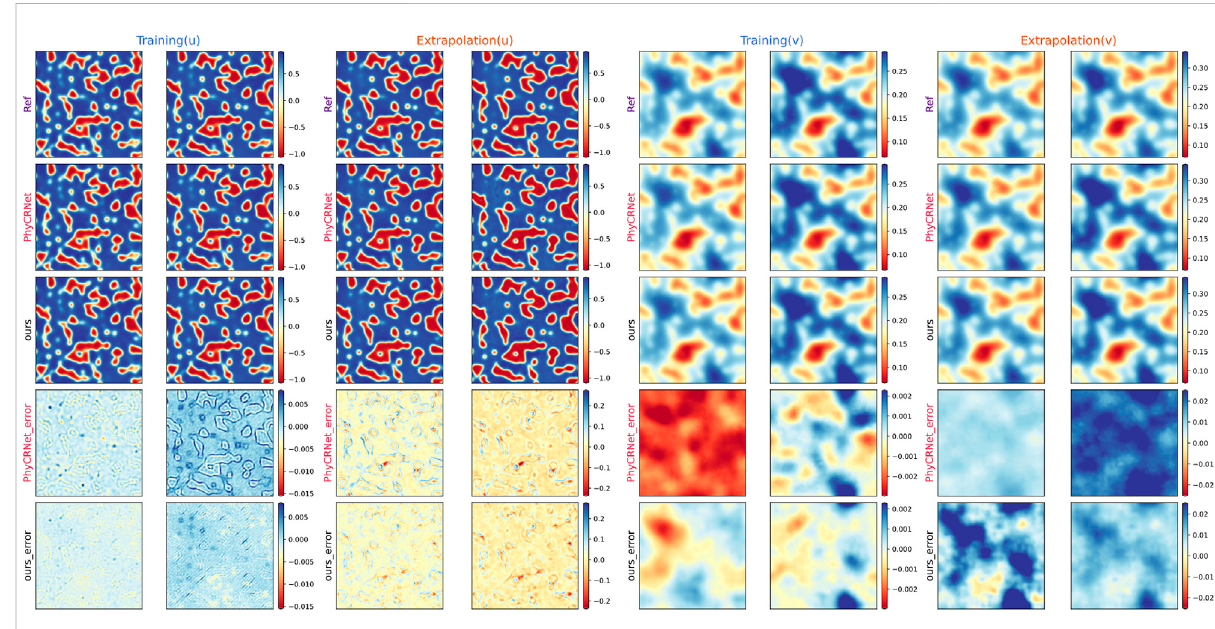
The results of Fourier fi lter-based PhyCRNet and PhyCRNet network solving the FitzHugh – Nagumo RD equations. Four representative momentsare selectedfor comparisonastraining (t =0.6,1.2 s)and extrapolation (t=1.8,2.4 s),andtheerrorsacrosstheinterval arecompared.The sub fi gures from top to bottom are reference solutions, predictions by PhyCRNet and ours, and errors of PhyCRNet and ours,